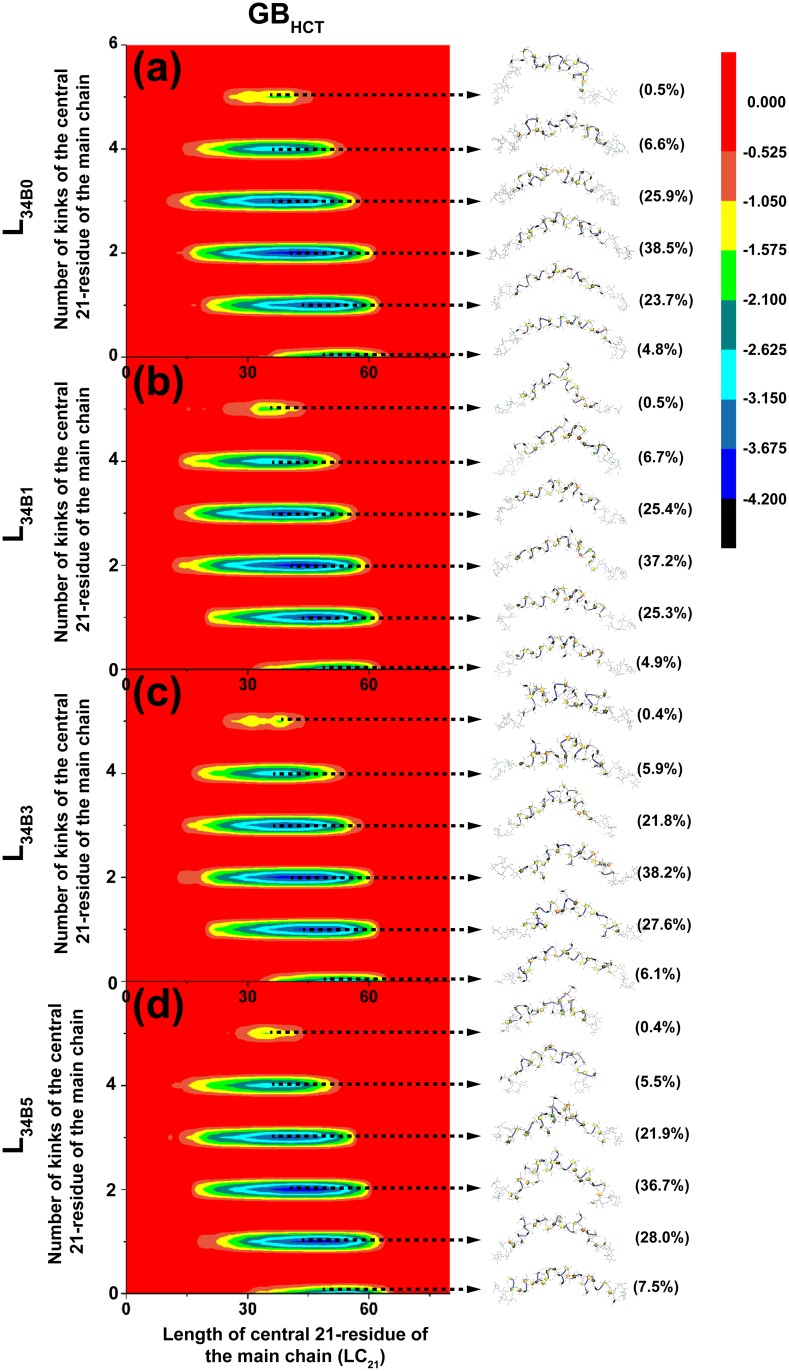
Relative free energy (kcal/mol) maps of L34B0 (a), L34B1 (b), L34B3 (c) and L34B5 (d) simulated in the GBHCT model, as characterized by the number of kinks of the central 21 residue region of the main chain and LC21.Their major representative conformers and populations are also shown.